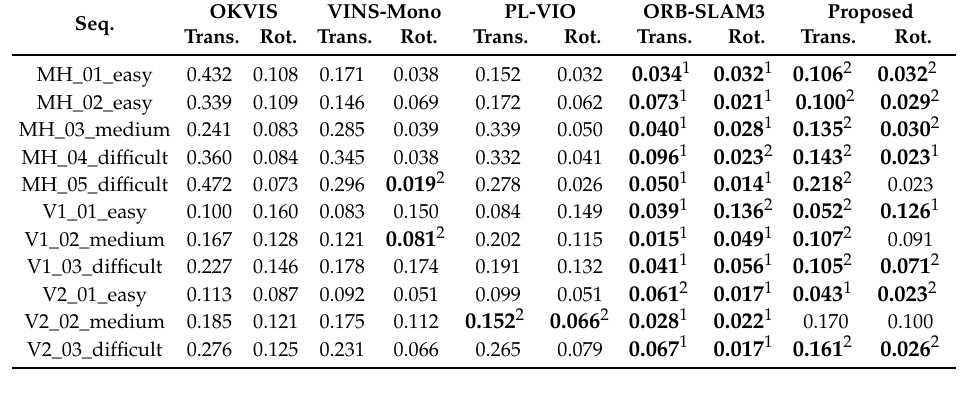
Table 1. The root mean square error (RMSE) of translation and rotation in all the EuRoC dataset sequences. To be easily recognized, the top 2 results of translation and rotation estimation are represented in bold fonts.